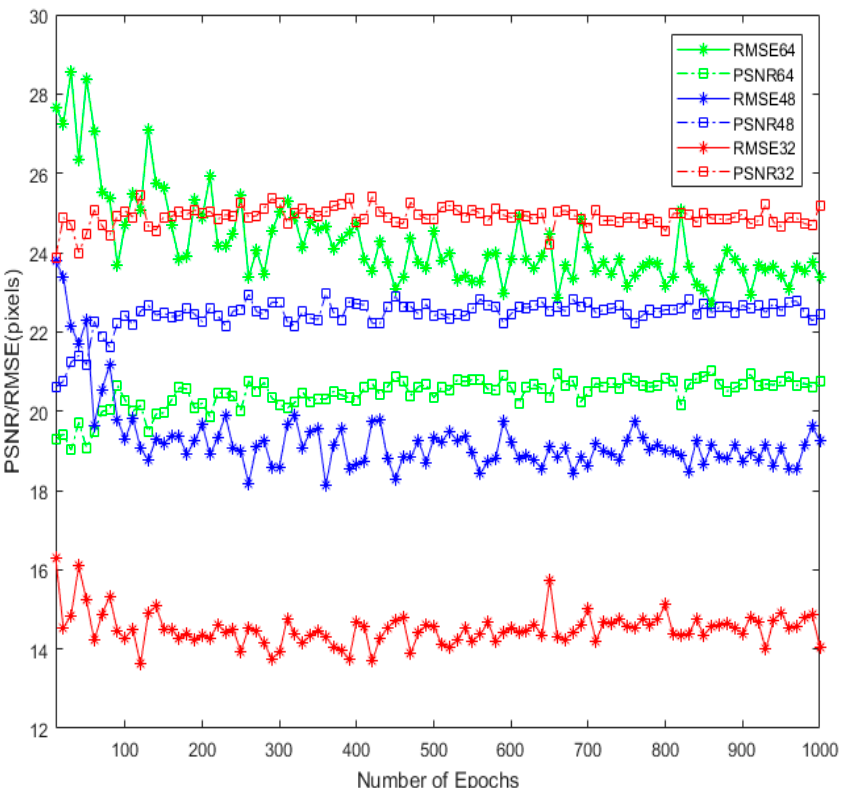
Figure 5. Testing of the test video frames extracted at 30 fps using different epoch models trained on the training dataset.